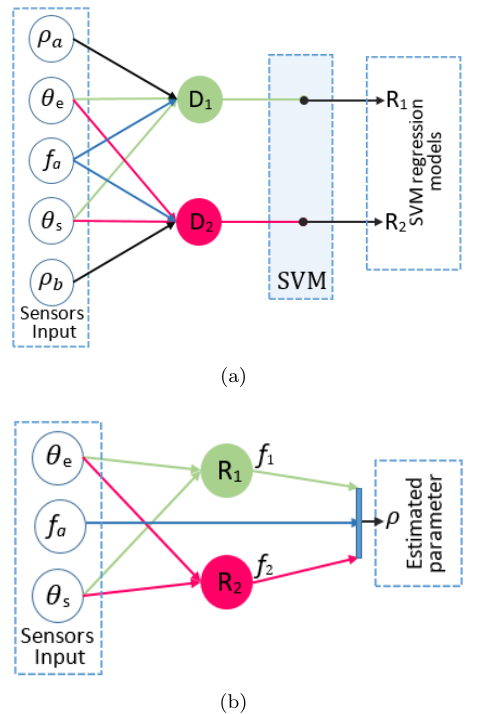
Figure 4: Flow diagram of algorithm design, (a) SVM training session to compute regression mod- els, (b) real-time estimation of payload. A 3D surface plot illustrating the MCI variation with respect to θ e and θ s is shown in Fig. 5.